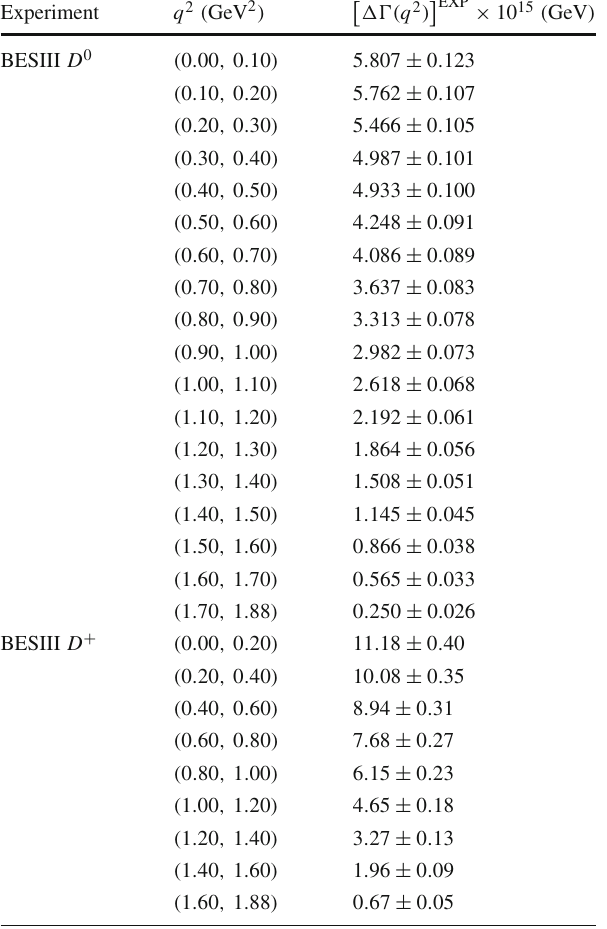
) from the BELLE collaboration [4], i